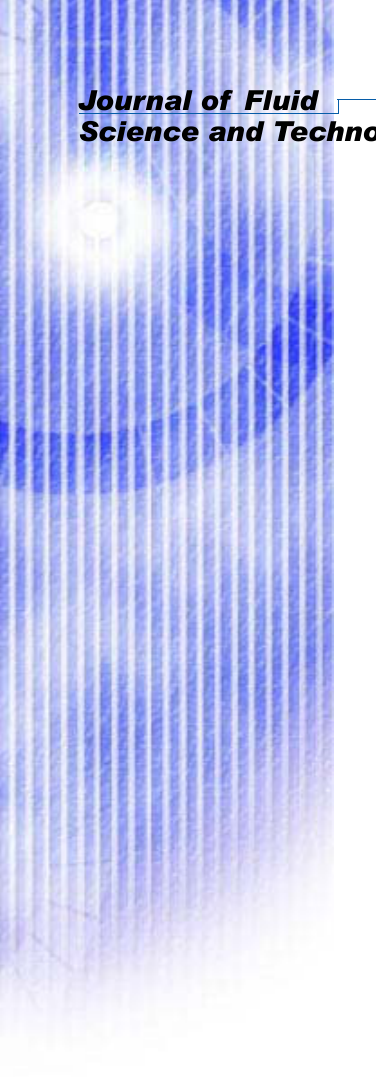
Fig. 10 Relationship between Q * m and Fr c . The solid line and dashed line are drawn by using Eq. (6) and the theoretical formula derived by Thomas, respectively; the solid circles show the experimental data of the present study; the data of other researchers is indicated by a number of different symbols.